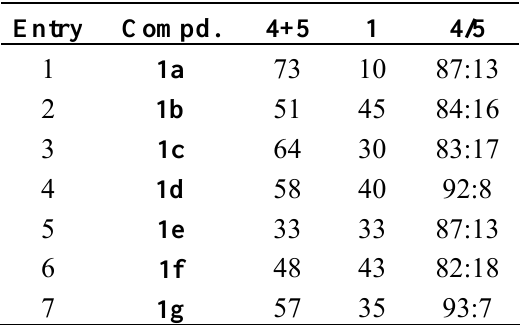
Table 3 . Azido selenenylation of compounds 1a - g